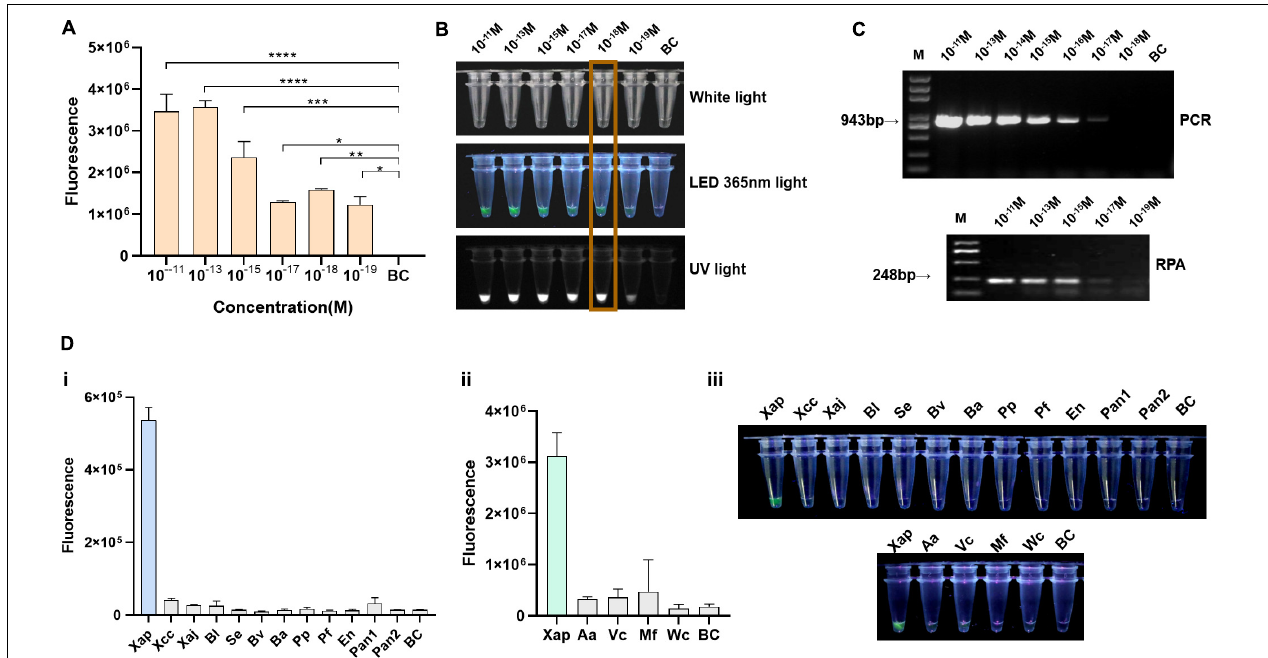
FIGURE 3 | Sensitivity and specificity of the RPA/Cas12a-fluorescence assay. (A) Sensitivity of the RPA/Cas12a-fluorescence assay. (B) Visualized results of the RPA/Cas12a-fluorescence assay. (C) Sensitivity of the PCR and RPA assay. BC, blank control. (D) (i) Specificity assessment of RPA/Cas12a-fluorescence assay with Xap and bacterial species; (ii) specificity assessment of RPA/Cas12a-fluorescence assay with Xap and other fungal species from the peach; and (iii) visualization of (i) and (ii) with a torch at 365 nm